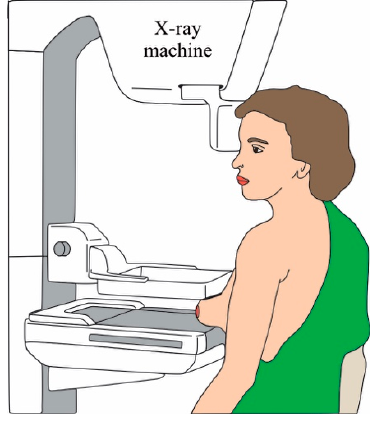
Figure 2. Mammography procedure.